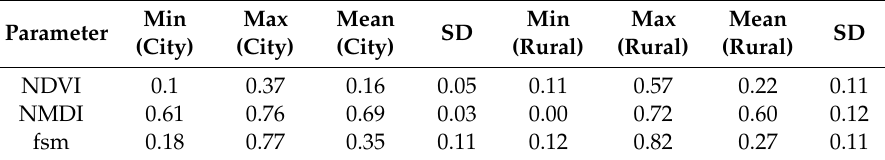
Table 4. Min, max and mean of NDVI, NMDI and fsm of Erbil city and rural area of 12 years from MODIS